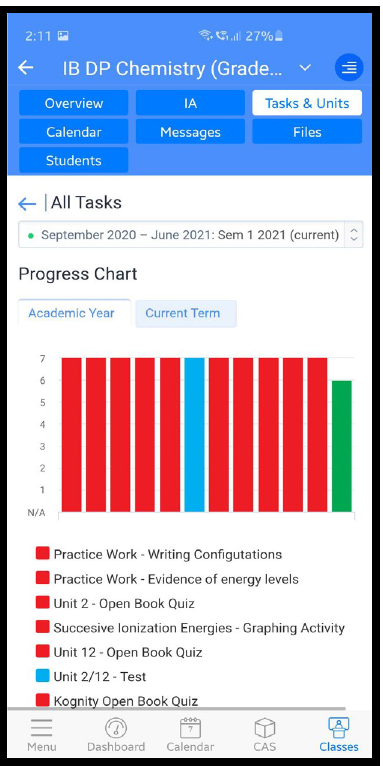
Figure 4 c. Student View of